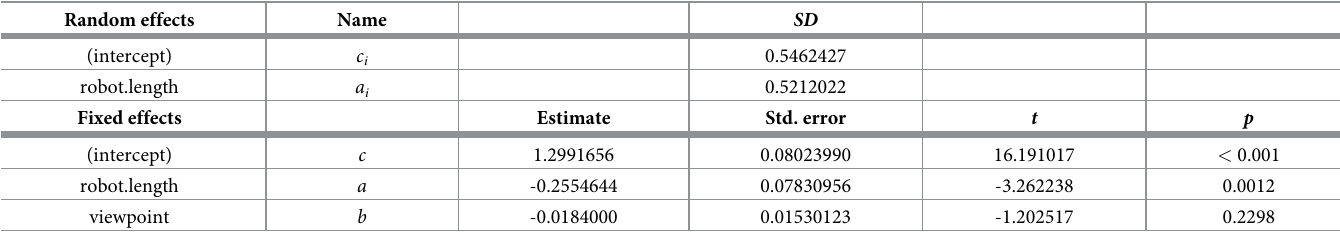
Table 5. Results of the linear mixed model (5) for predicted back-off